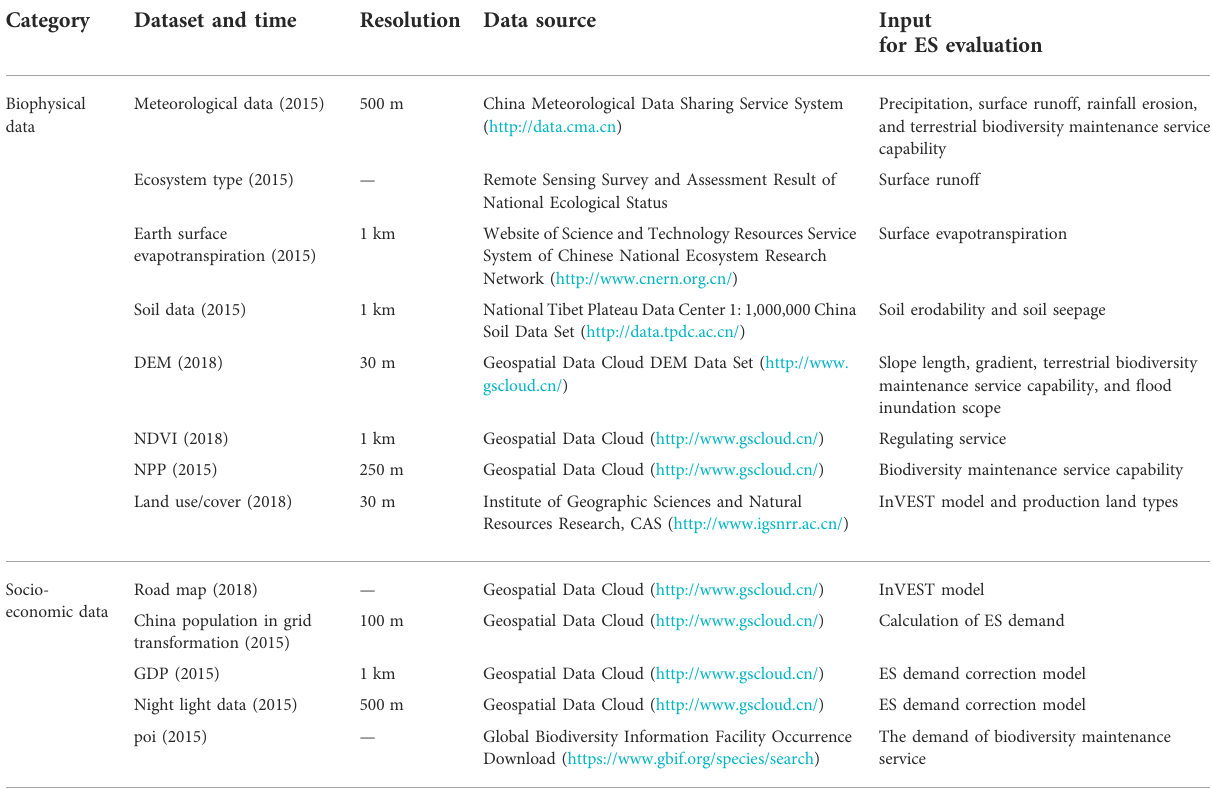
TABLE 1 Sources for input